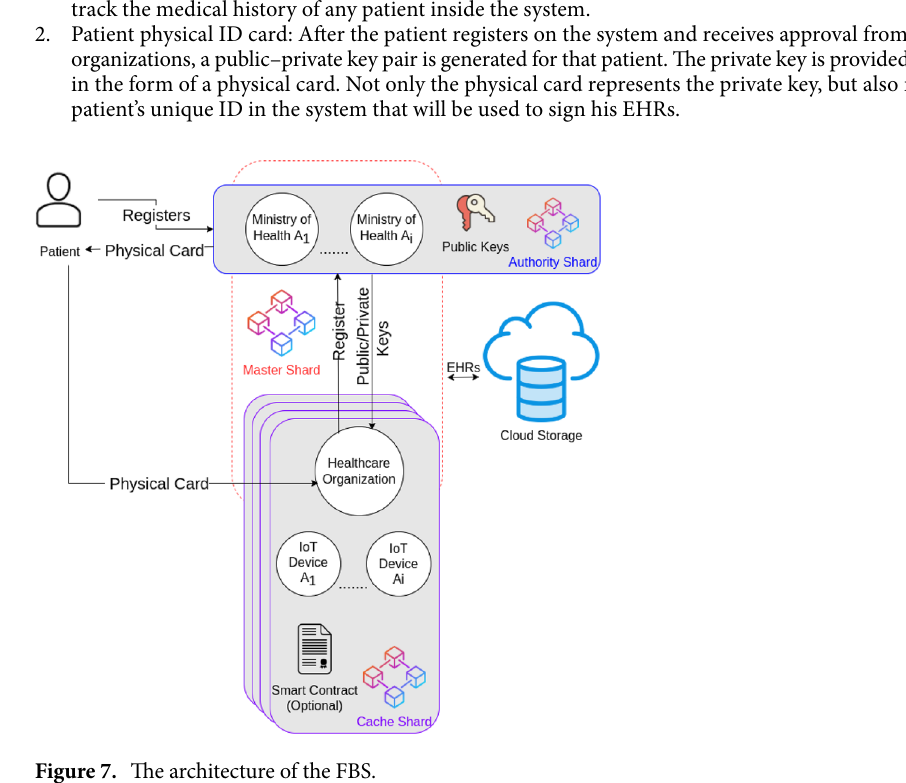
Figure 7. The architecture of the